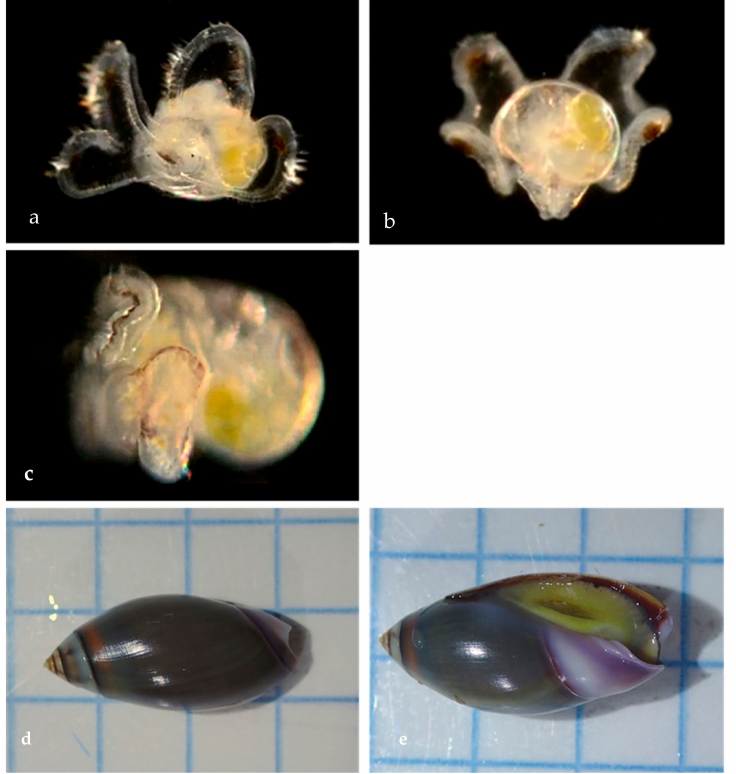
Figure 17. Family Olivellidae. Purple dwarf olive , Callianax biplicata (BINACB8152; n = 8 veligers + 2 adults pending). ( a ) Veliger CCDB-24722-H05 from Newport Beach Harbor entrance. ( b ) Veliger CCDB-24722-H07 from Newport Beach Harbor entrance. ( c ) Veliger CCDB 31597 F10 from Ocean off Newport Beach. ( d ) Adult, dorsal CCDB-32329 G10 from Balboa at Coral. ( e ) Adult, ventral CCDB-32329 G09 from Balboa at Coral. Background 1 ⁄ 4 inch squares. Order Cephalaspidea: Sea Slugs and Bubble Snails Family Gastropteridae Swainson, 1840 [1] Bat-Winged Slugs Adults have no shell, or an internal reduced shell (Figure 18). They have outgrowths from the mantle wall called parapodia, used in